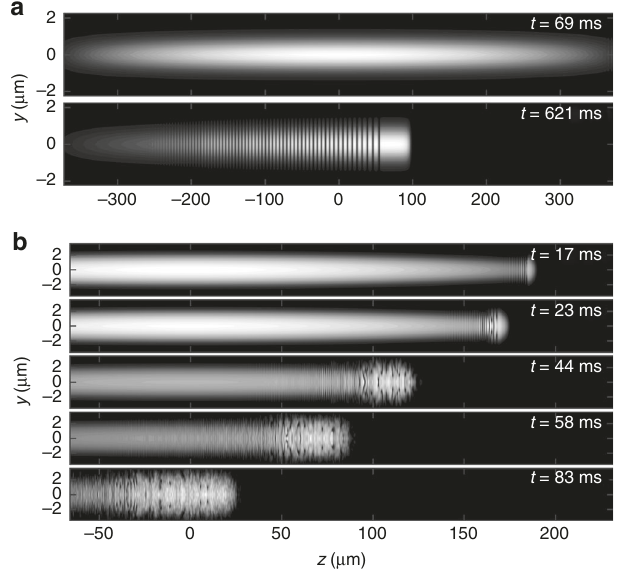
Fig. 3 Integrated cross sections of numerical simulations. a Quasi-1D dispersive shock wave in low atom number regime where v p = 0.41 mm s − 1 . b Development of 3D turbulence and a viscous shock wave in the large atom number regime where v p = 2.44 mm s −